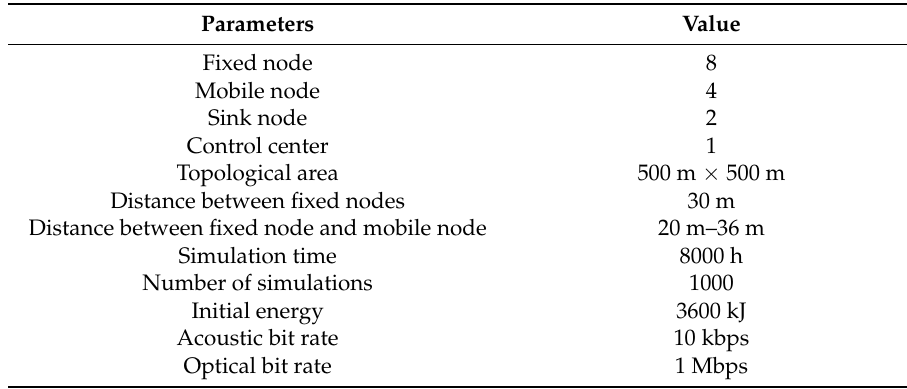
Table 4. System simulation